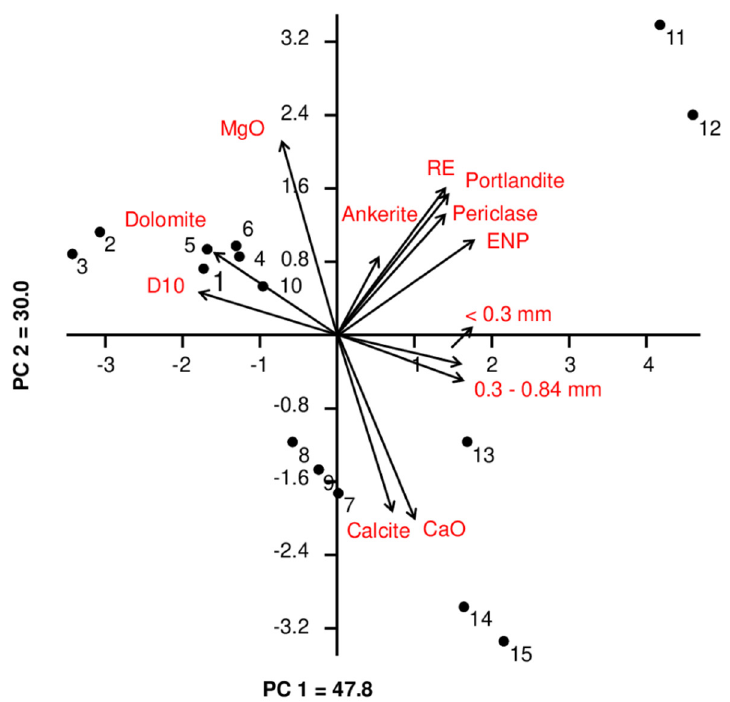
Figure 4. Principal component analyses considering liming product samples (number), mineralogy, and physical and chemical analyses of liming product samples. Data set used for ( n = 15 samples). The principal components (i.e., axes PC1 and PC2) explain the magnitudes in the percentage of data variability. D10 is the % of particle size smaller than 10%. <0.30 and 0.3–0.84 mm corresponding to the size fractions. RE is the reactivity efficiency and ENP is efficiency neutralizing power.